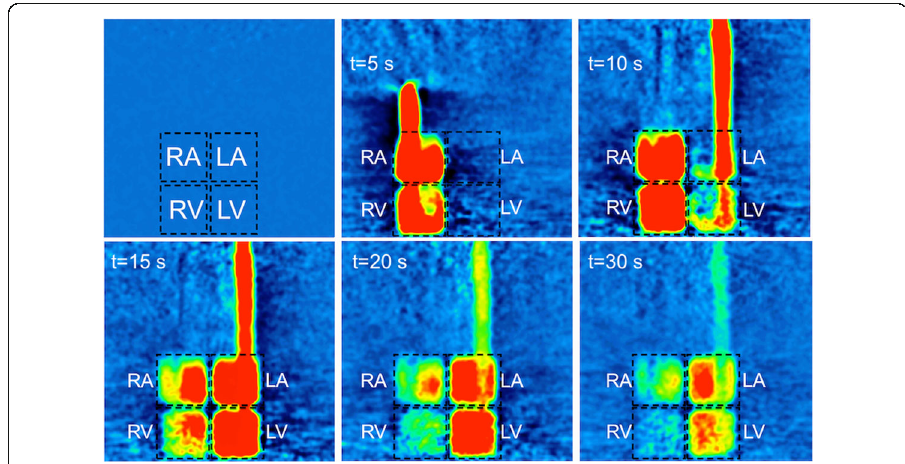
Fig. 2 Single coronal PET slice from the 3D phantom acquisition at a cardiac output rate of 3 L/min, showing an example of radiotracer distribution in the myocardial chambers at increasing post-injection time points. All images are shown at the same windowing and level. RA/LA = right/left atrium, RV/LV-right/left